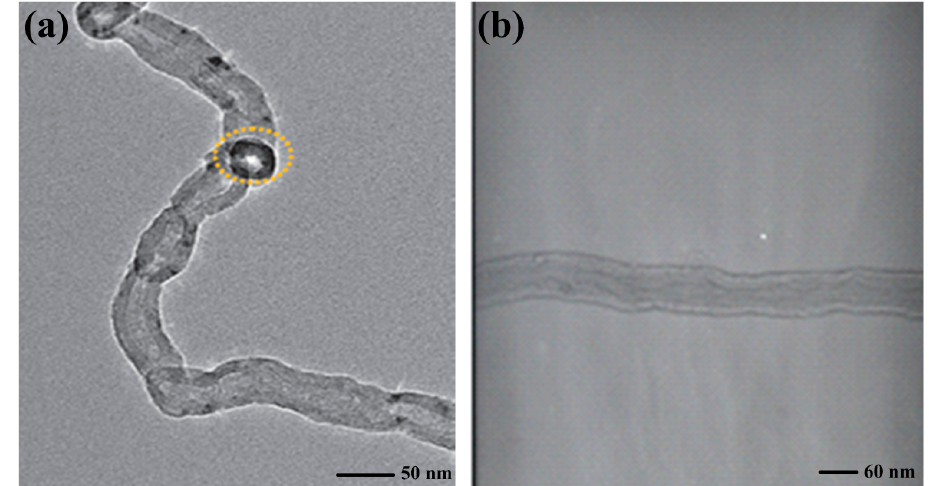
Figure 5. ( a ) Thickly walled carbon filament produced using iron(III) chloride catalyst (yellow dotted circle); and ( b ) the nickel(II) chloride catalyst produced nanotubes with symmetrical walls.